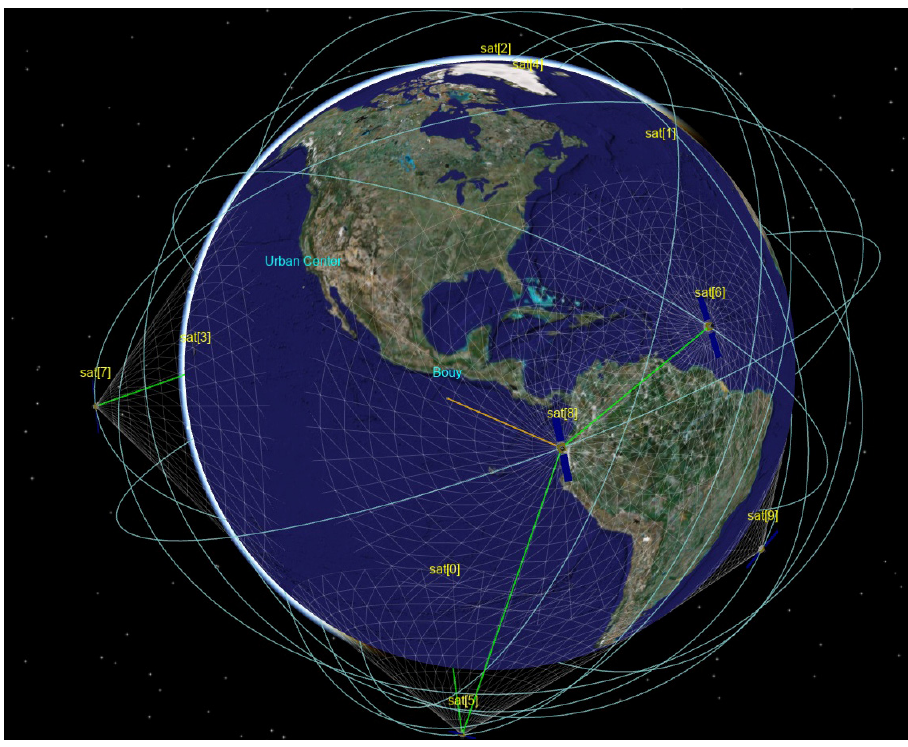
Figure 2. Simulation scenario with the selected coordinates for a buoy and urban center.